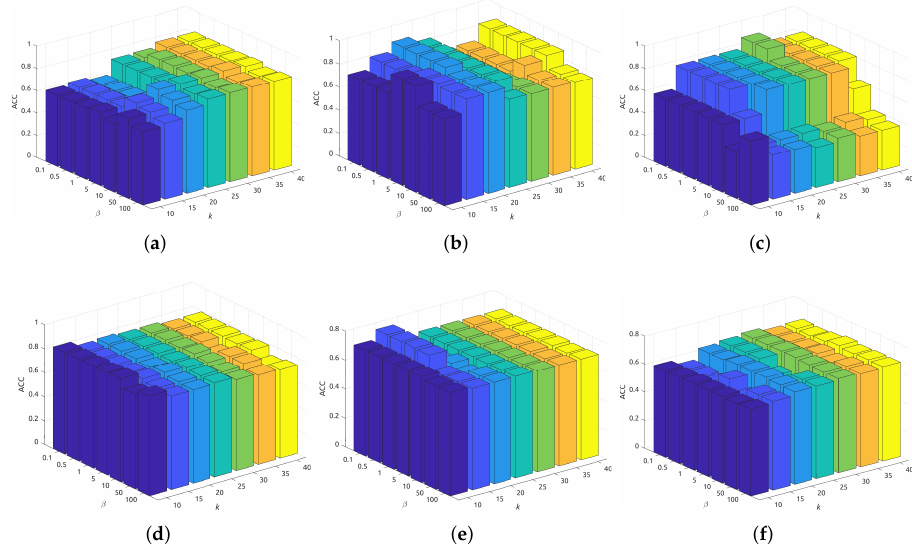
Figure 4. Accuracy (ACC) with respect to β and the number of neighbors ( k ). ( a ) 3Sources. ( b ) MSRC. ( c ) BBCSport. ( d ) COIL-20. ( e ) Caltech-7. ( f ) Caltech-20.